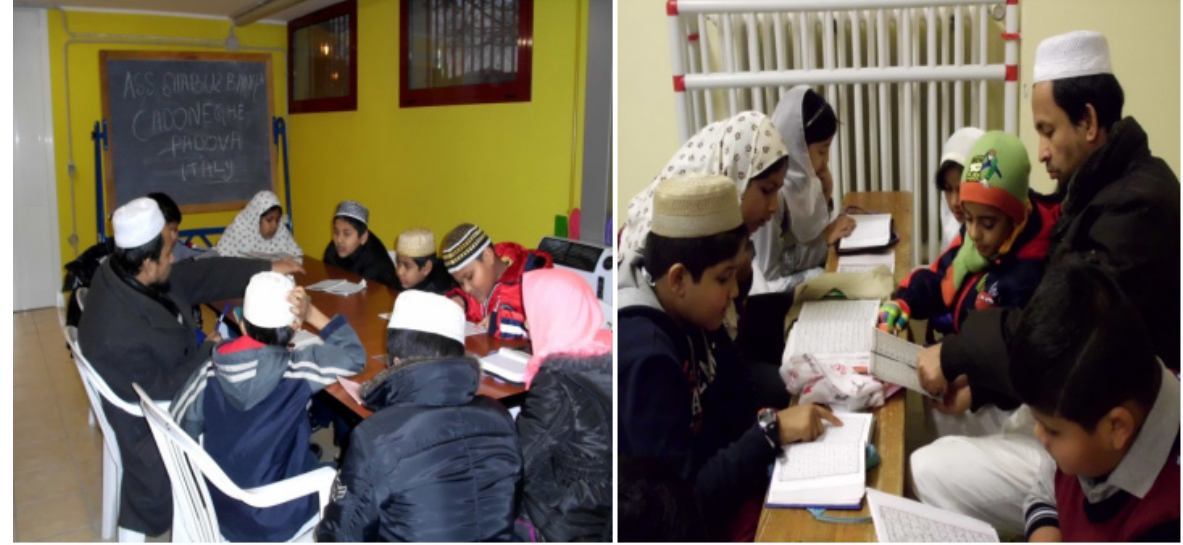
Figure 2. Children of the Bangladeshi community in Padova learning the Quran from a Bangladeshi religious teacher. Source: Fieldwork (2013).